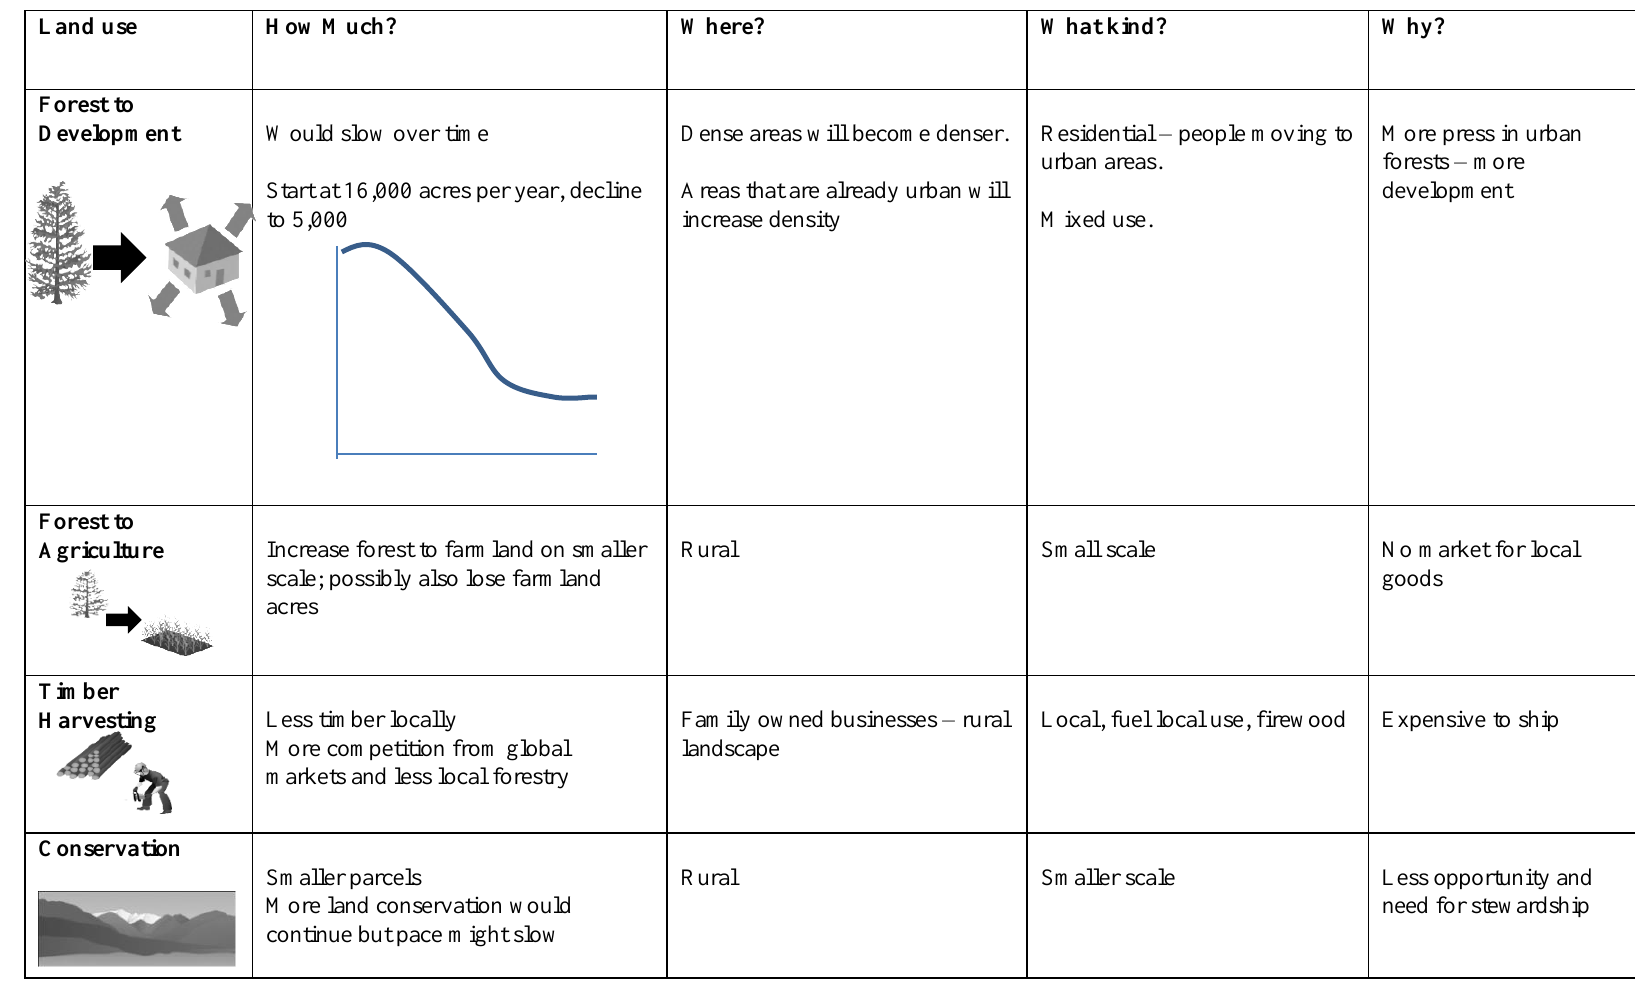
Table A2.8. Scenario 4: Urban